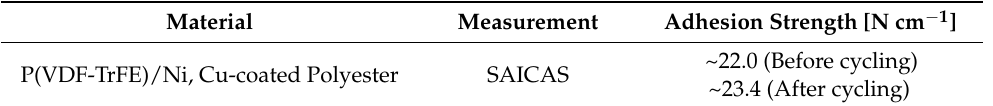
Table 2. Interfacial adhesion strength